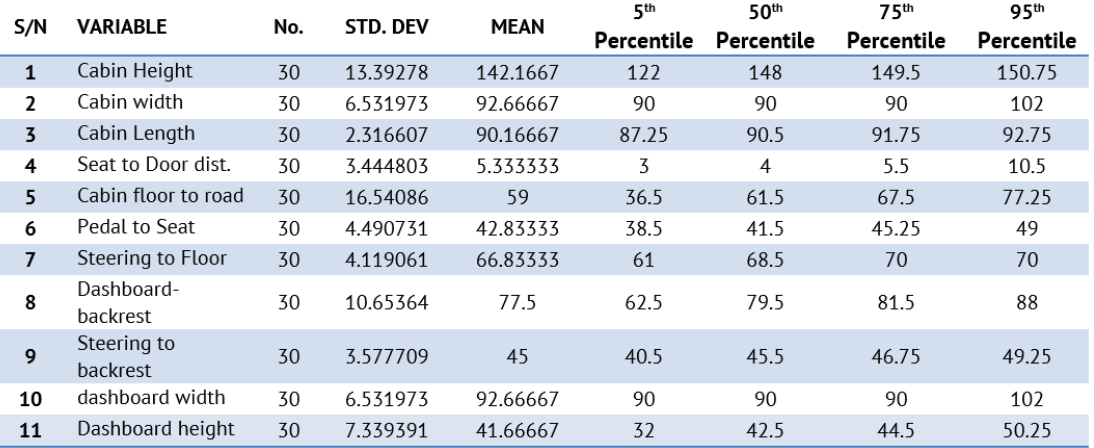
Summary of data obtained from mini bus workstations (Category